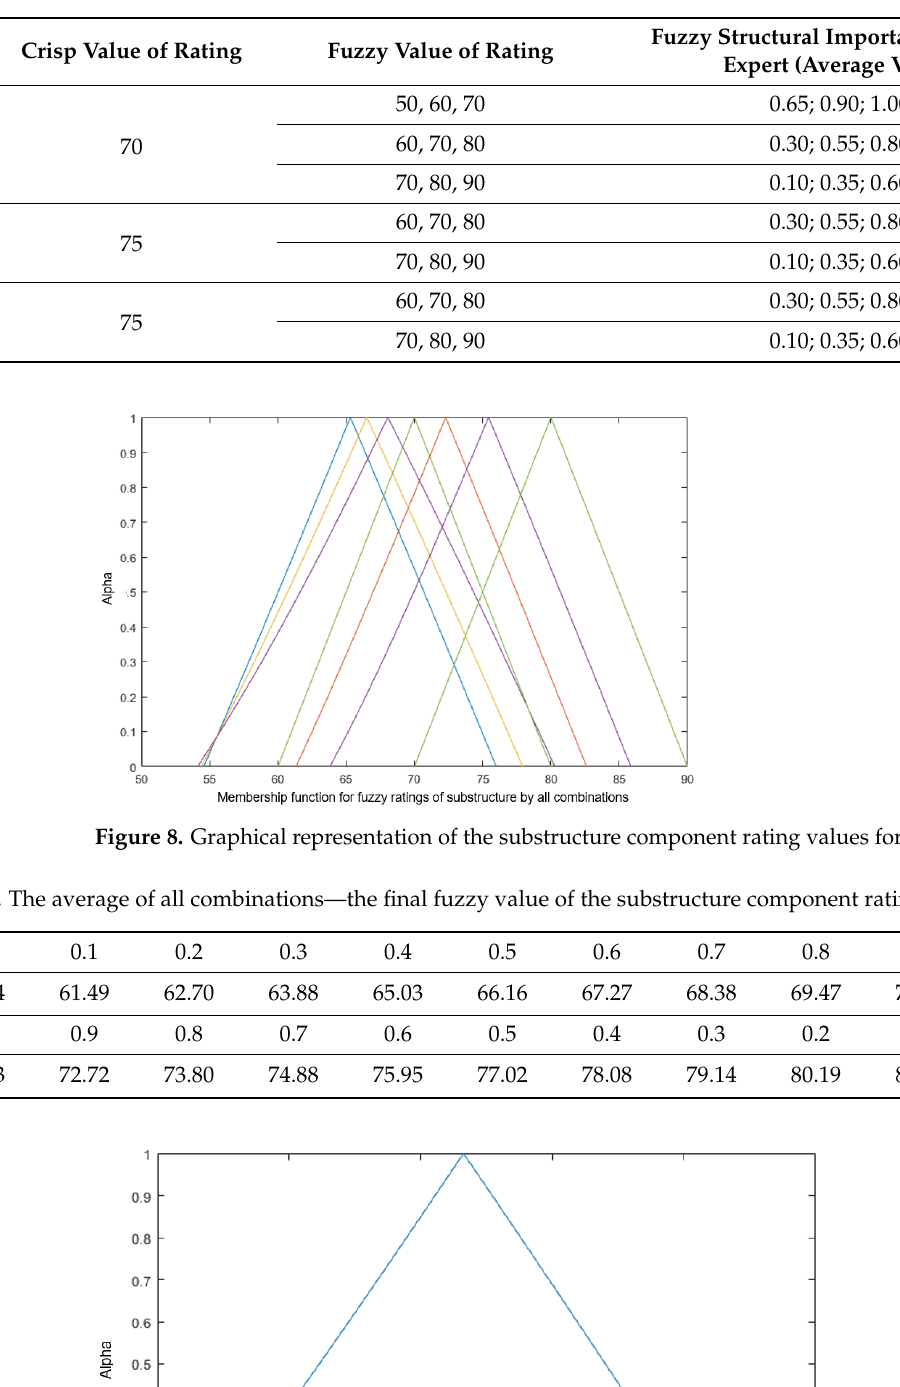
Table 10. Crisp and fuzzy values of ratings of the substructure component elements.